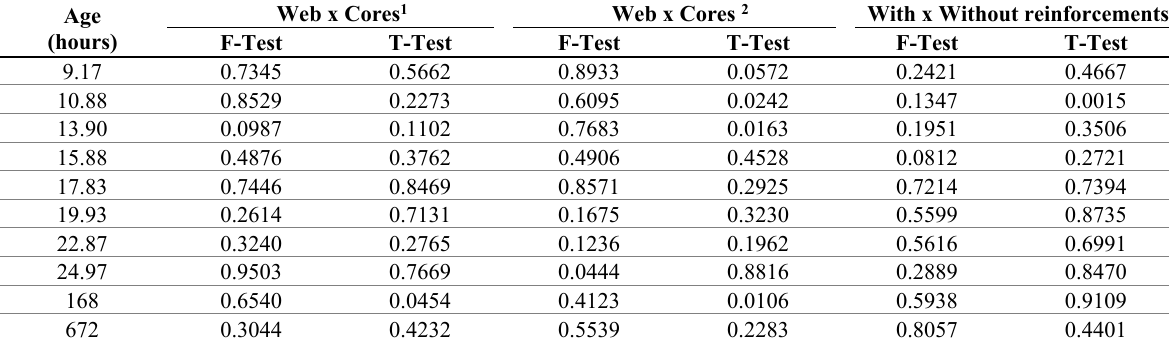
Table 6 – Probabilities of F-Test and